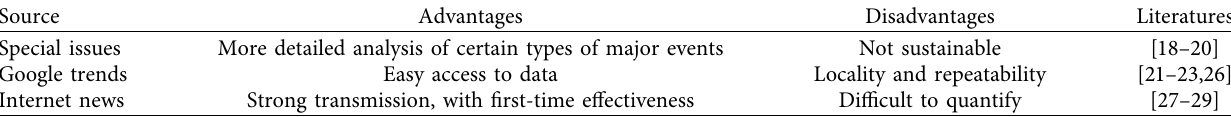
Table 1: Representation and characteristics of Internet